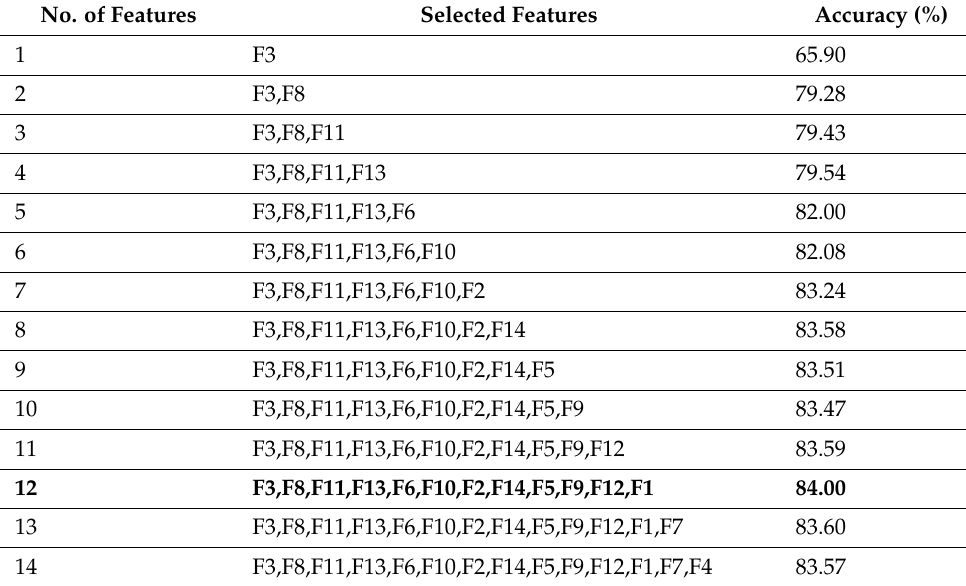
Table 6. Performance of fault detection using SFS with ELM (five-fold